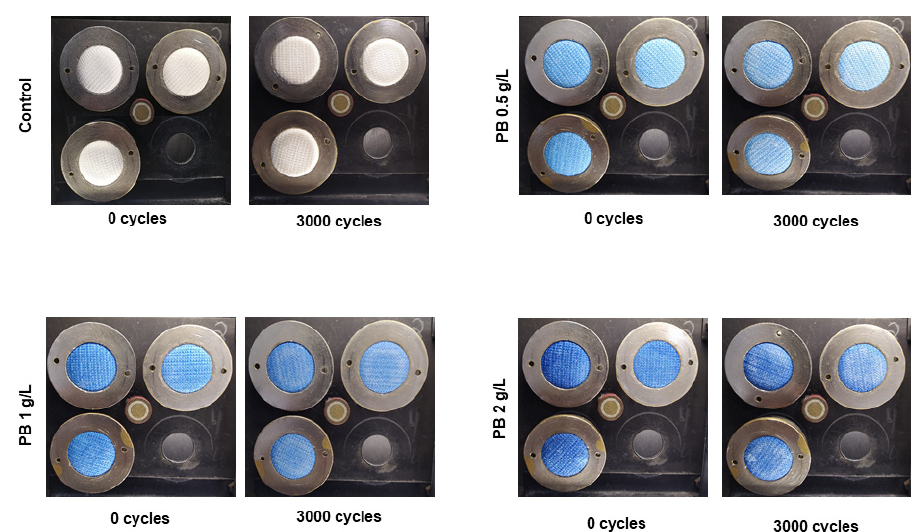
Figure 3. Visual results for polyester knits coated with Prussian blue (PB) at different concentrations (0.5 g/L, 1 g/L and 2 g/L) before and after 3000 cycles in the Martindale machine. Table 3. Weight loss percentage of polyester knits coated with Prussian blue (PB) at different con- centrations (0.5 g/L, 1 g/L and 2 g/L) after 3000 cycles in the Martindale machine, (n = 3, ± SD). WEIGHT LOSS ± SD (%) Control